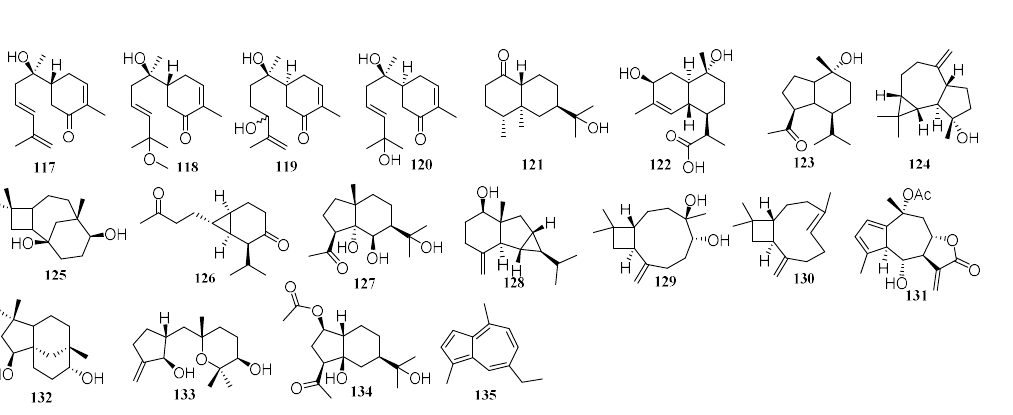
Figure 6. Other types of sesquiterpenoids from the Chrysanthemum genus.